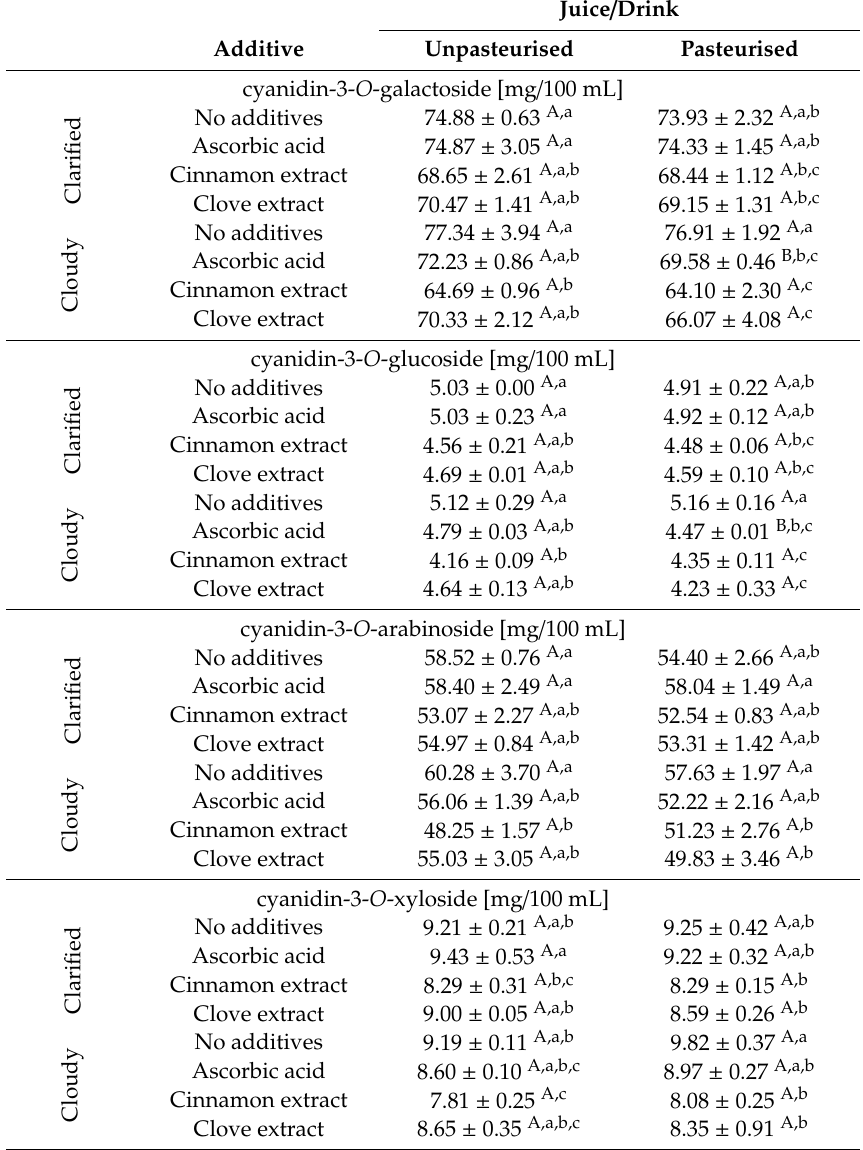
Table 3. Cyanidin content before and after juice / drink